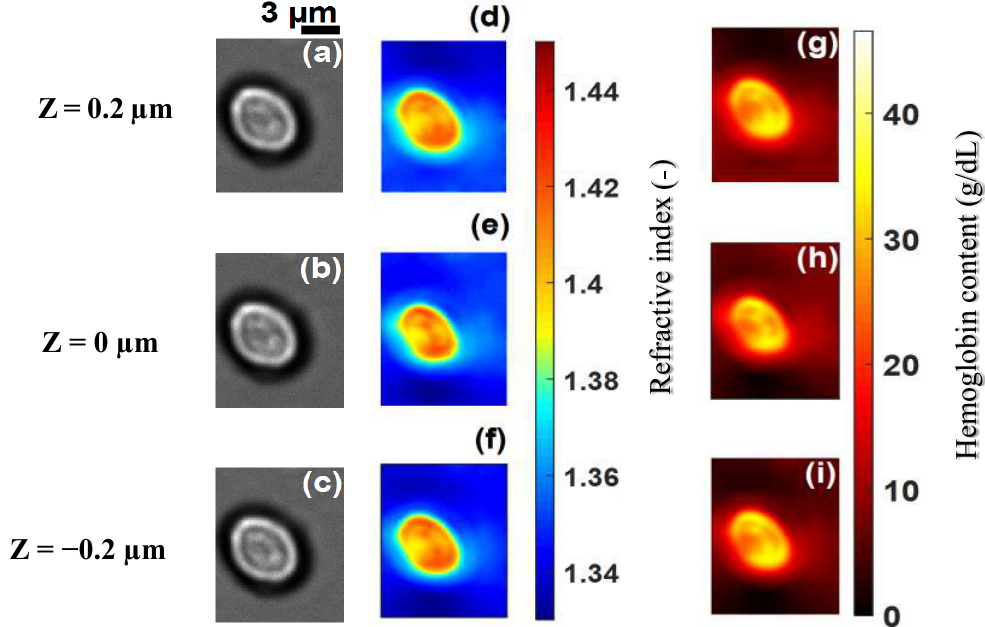
Figure 3. Recorded images of healthy cell A at the wavelength λ = 800 nm for different z planes ( a )–( c ) its corresponding refractive index distribution ( d )–( f ) and hemoglobin content ( g )–( i ). The selected images are representative of a total of 102 healthy cells analyzed.